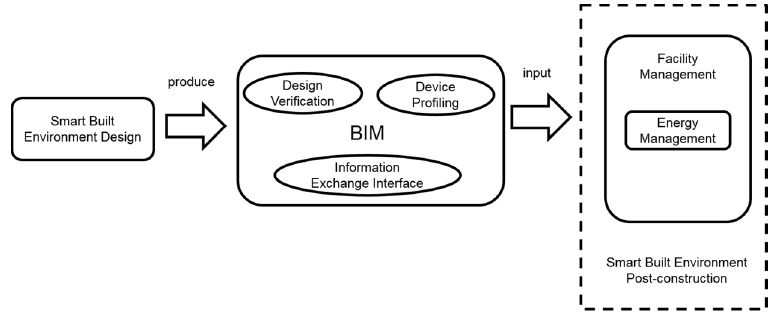
Figure 1. Role of building information modelling (BIM) in smart built